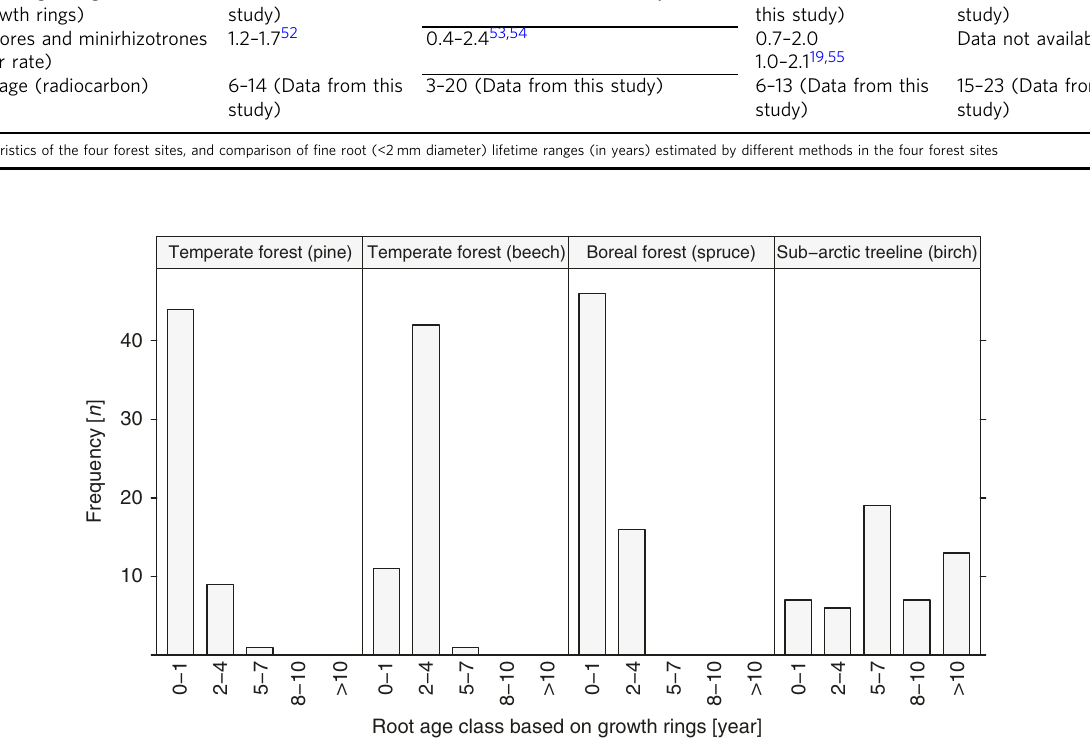
Fig. 2 Age class distribution of fi ne roots estimated by counting the number of annual growth rings. The age class distribution of fi ne roots with a diameter size of <2 mm was estimated by counting the number of annual growth rings in the secondary xylem of fi ne-root samples of different climate zones with different dominant woody